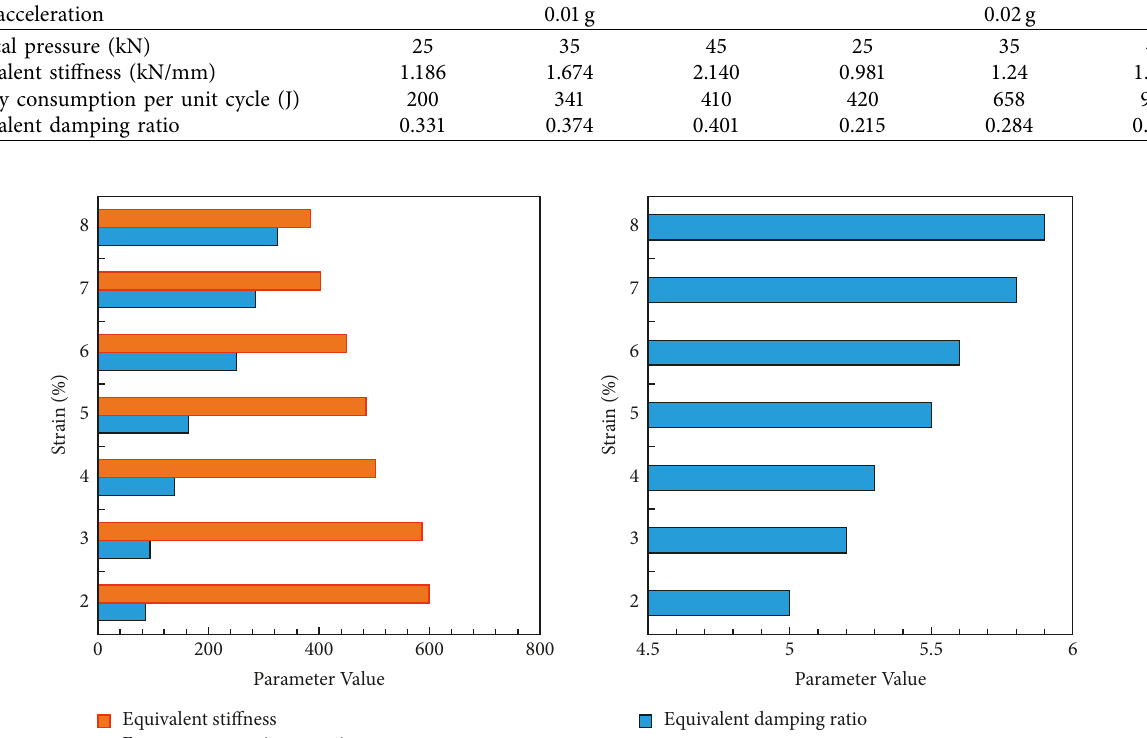
Figure 10: Cyclic loading test of isolation